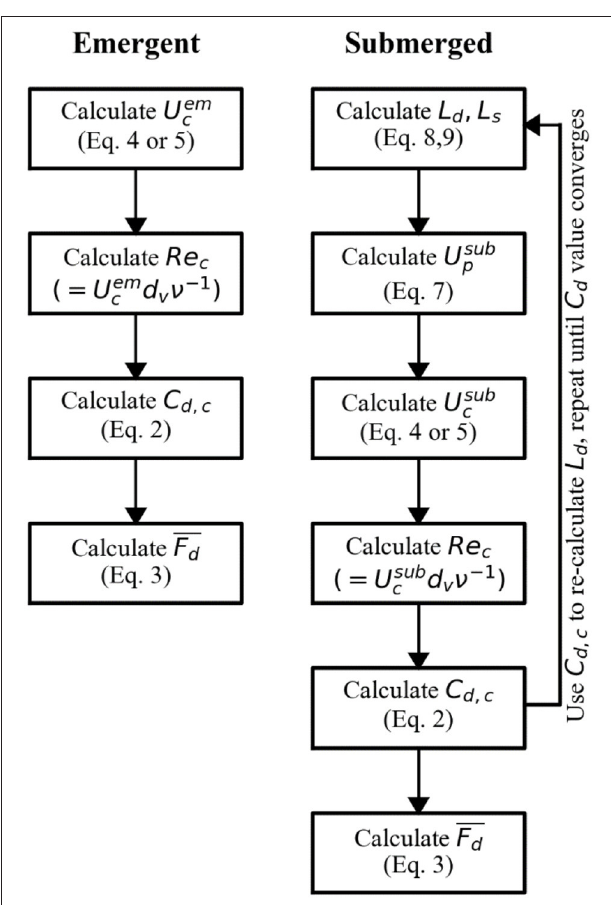
FIGURE 2 | Flow diagram for the canopy drag model. The model can be used to estimate the drag force on an individual element within an emergent or submerged canopy or the bulk canopy drag. As input, it requires above-canopy velocity ( U ) that can be estimated from the flow rate ( Q ) or ∞ bulk velocity ( U b ) for submerged and emergent canopies resp., local water depth ( h ), and the canopy properties: height ( h v ), stem diameter ( d v ), and canopy density ( λ p , N v ). For submerged canopies, an initial value of C d 1 (to = calculate L d ) is